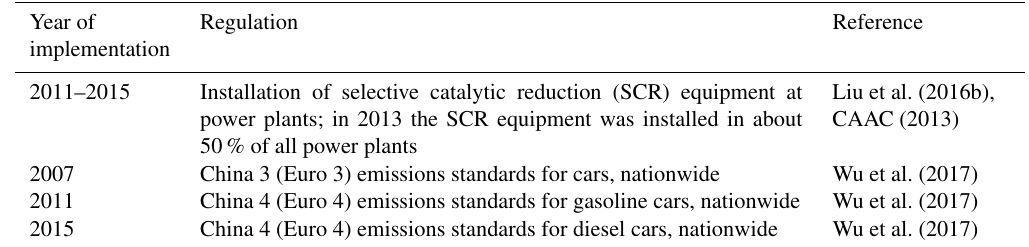
Table 2. Environmental regulations of the Chinese national government to reduce NO x emissions. Year